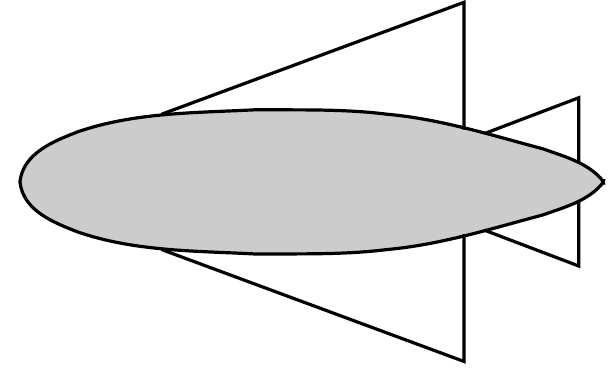
Figure 3. Airship with delta wings (Adapted from Ref.